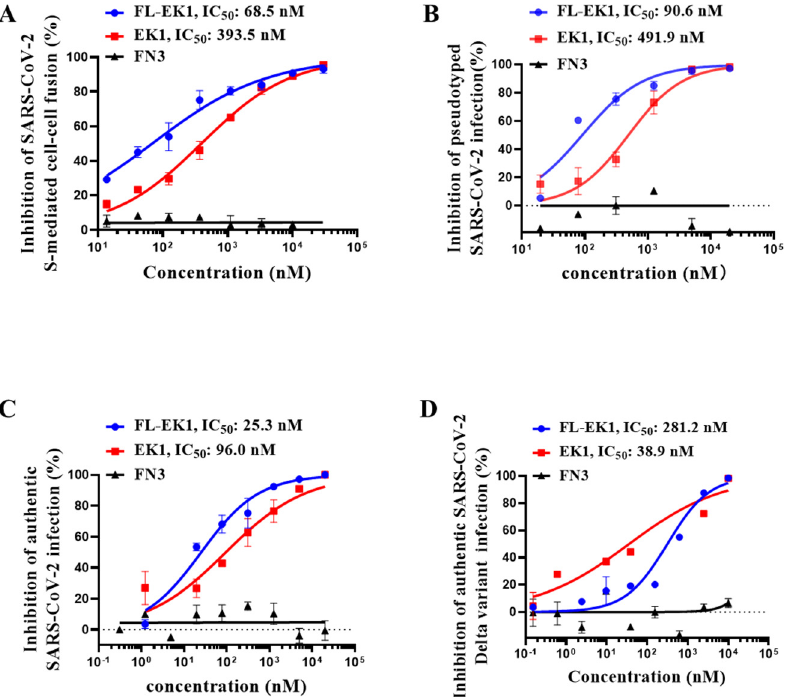
Figure 2. FL-EK1-mediated inhibition of SARS-CoV-2 infection. ( A ) FL-EK1-mediated inhibition of SARS-CoV-2 S-mediated cell–cell fusion. ( B ) FL-EK1-mediated inhibition of pseudotyped SARS-CoV-2. ( C ) FL-EK1-mediated inhibition of authentic SARS-CoV-2 infection. ( D ) FL-EK1-mediated inhibition of authentic SARS-CoV-2 Delta variant infection. Samples were tested in triplicate, and the experiment was repeated three times. Data from a representative experiment are presented as mean ± SD. Table 1. Inhibitory activity of FL-EK1 and EK1 against pseudotyped SARS-CoV-2 variants. Pseudotyped SARS-CoV-2